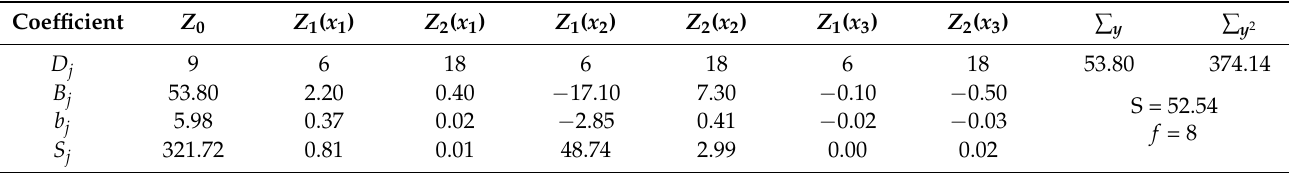
Table 5. Regression coefficient and calculation